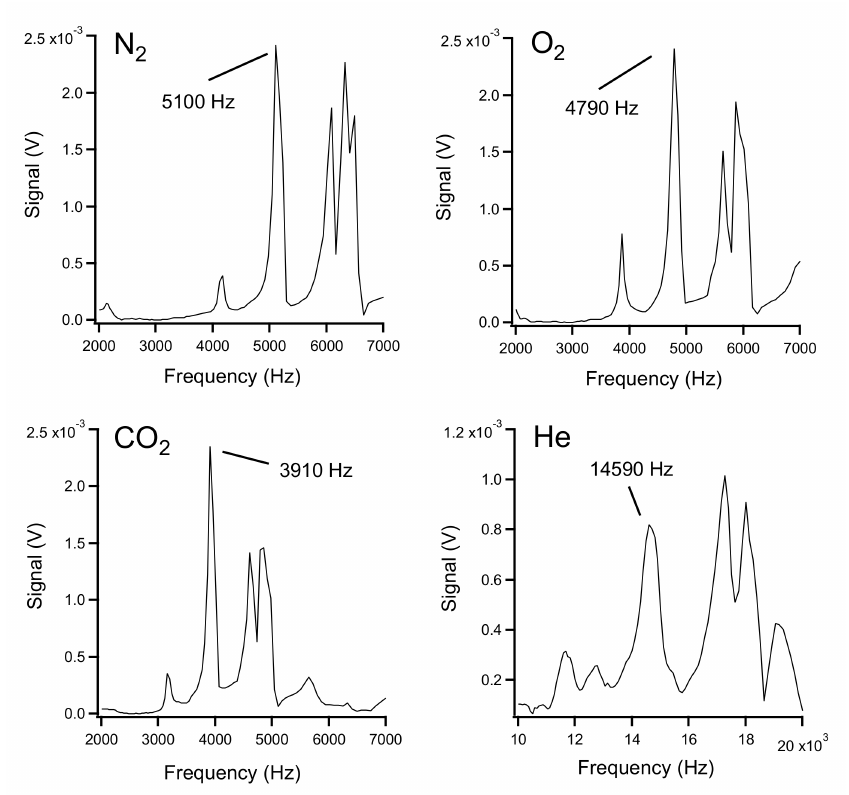
Figure 3. Resonance spectra for the four pure